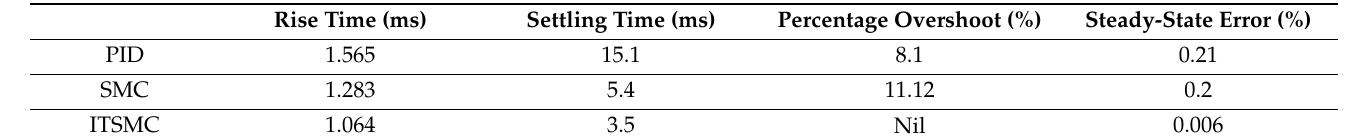
Table 5. Performance comparison between the PID, SMC and ITSMC.